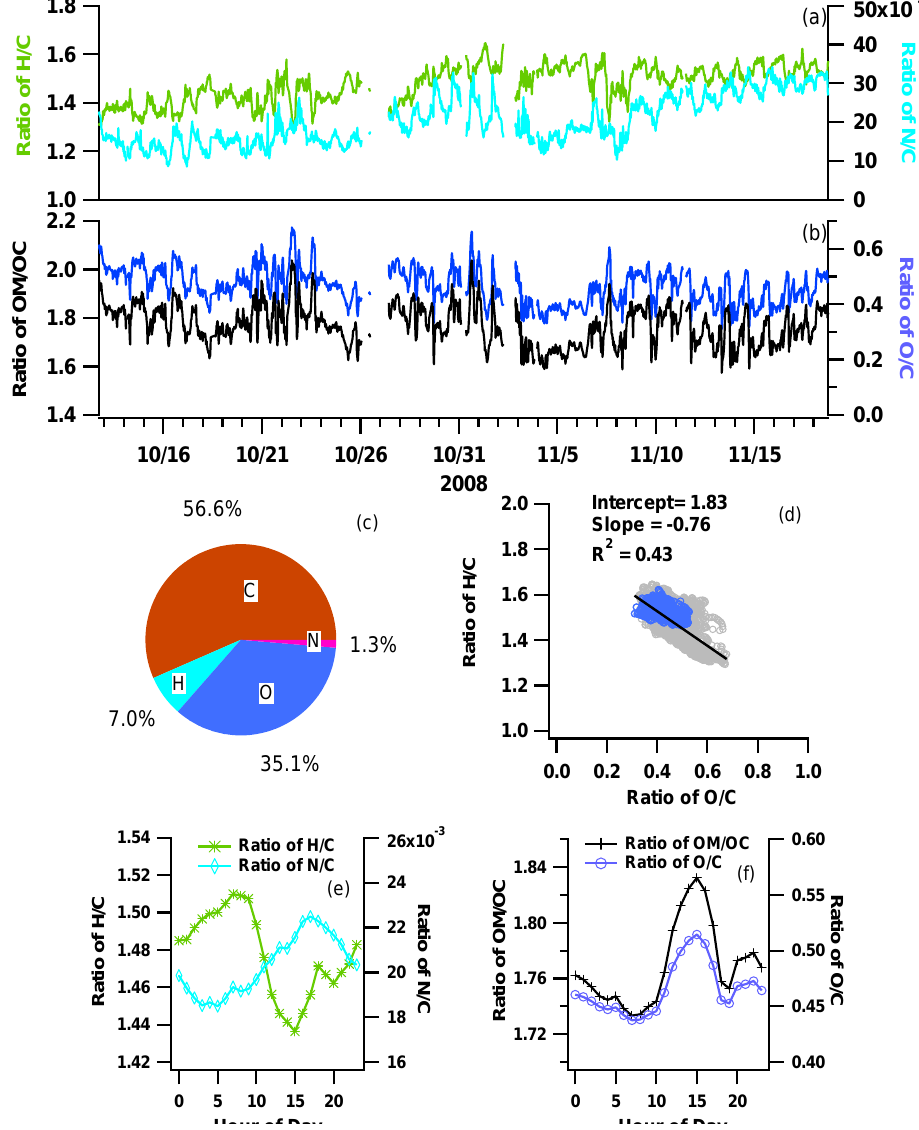
Fig. 4. The time series of (a) H/C and N/C ratios; and (b) O/C and OM/OC ratios; (c) the average mass-based organic elemental composition; (d) the Van Krevelen diagram (with data points during biomass burning period highlighted with blue); the average diurnal variations of (e) H/C and N/C ratios and (f) O/C and OM/OC ratios.